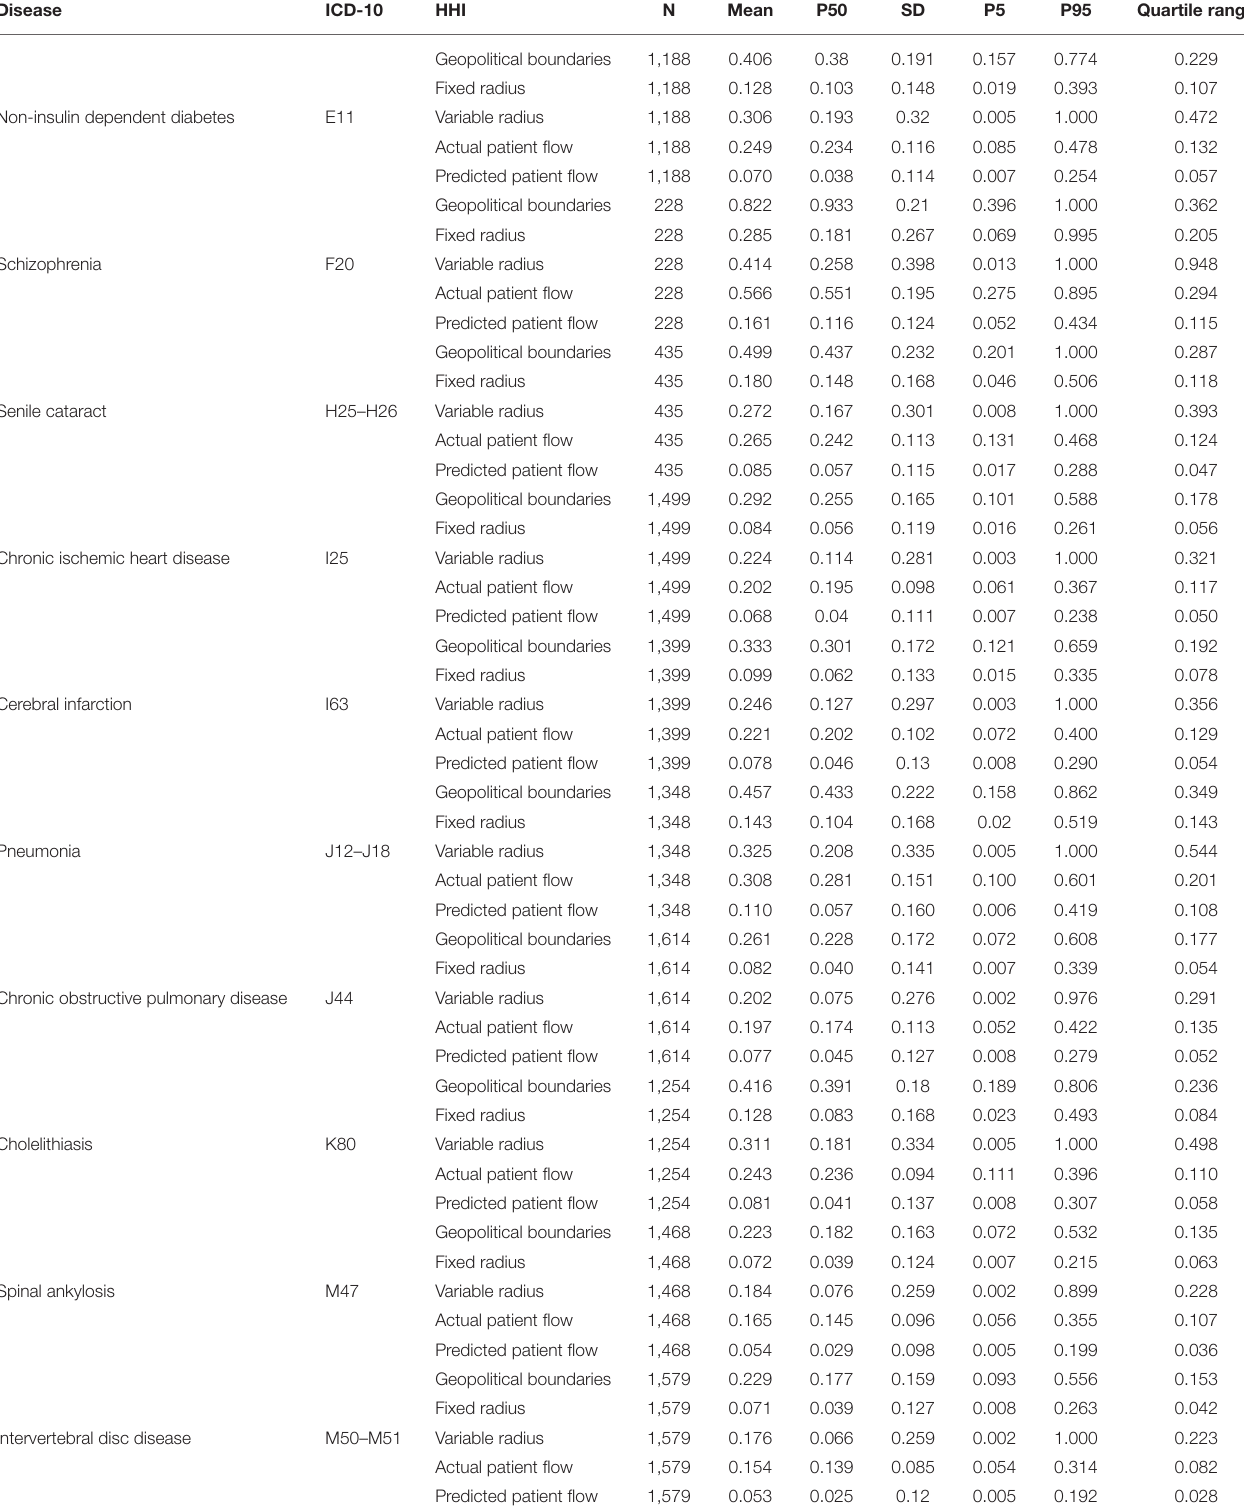
TABLE 3 | Descriptive analysis of HHIs based on different definition methods of selected diseases.